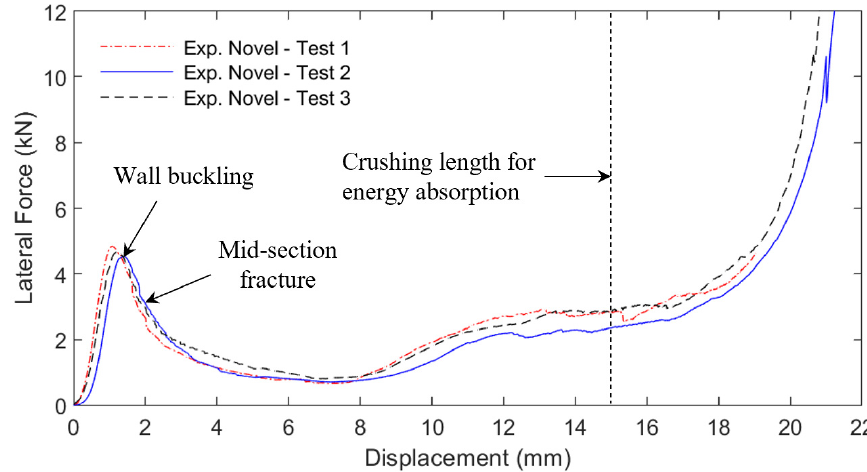
Figure 11. Experimental load vs. displacement curves for novel cell under lateral load.